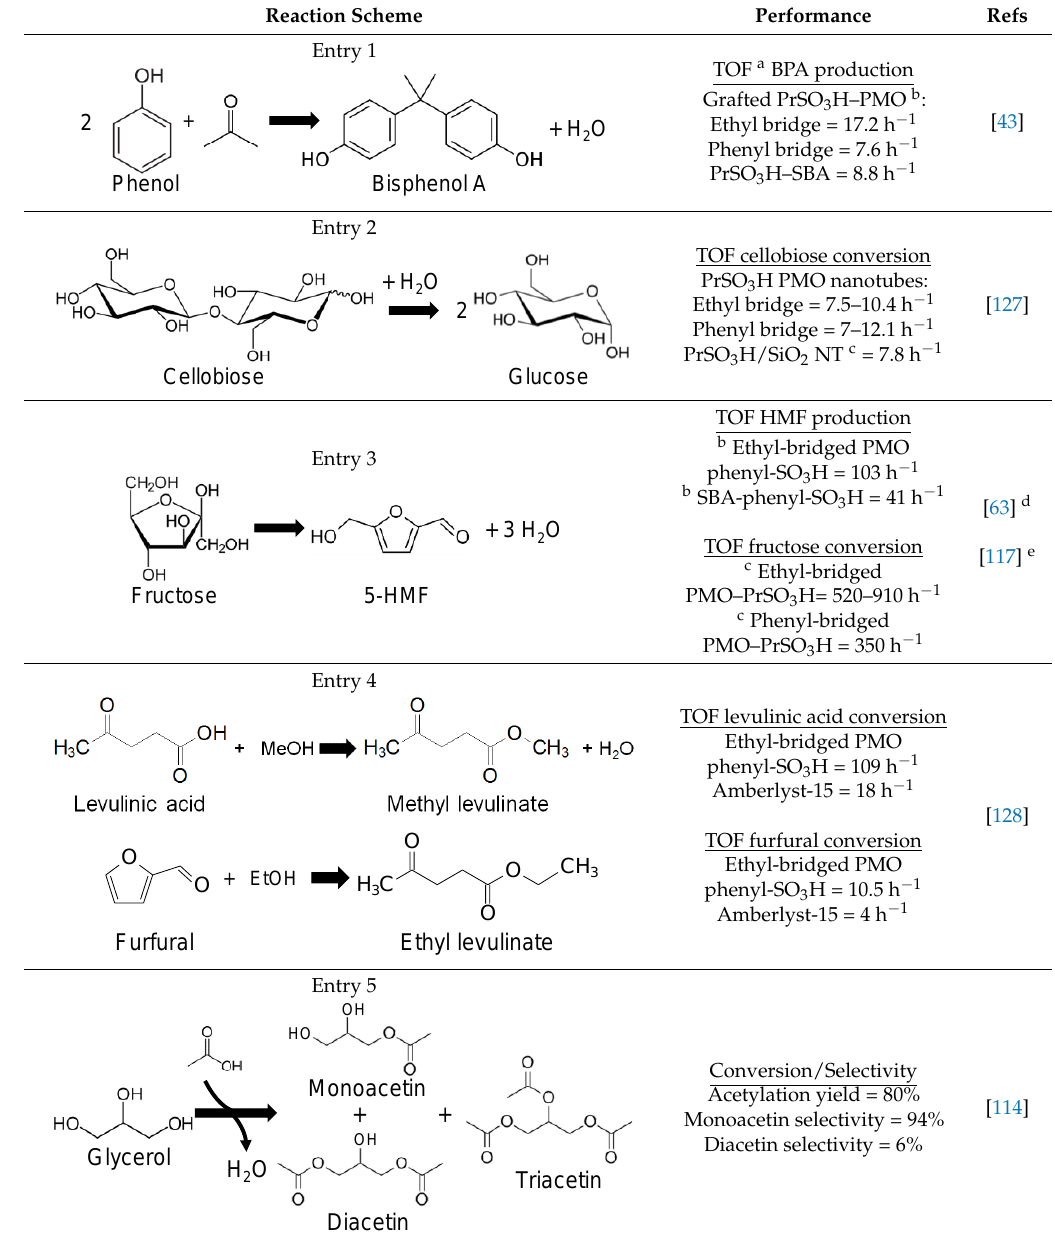
initial gel, which gave materials with optimal hydrophobicity to eliminate water from the acid site, and highest acid-site loadings and surface areas [126]. Table 1. Reaction schemes and performance of periodic mesoporous organosilica (PMO) sulfonic Table 1. Reaction schemes and performance of periodic mesoporous organosilica (PMO) sulfonic Table 1. Reaction schemes and performance of periodic mesoporous organosilica (PMO) sulfonic acids. Entry 1 — condensation of phenol with acetone to bisphenol A (BPA); Entry 2 — hydrolysis of acids. Entry 1 — condensation of phenol with acetone to bisphenol A (BPA); Entry 2 — hydrolysis of Table 1. Reaction schemes and performance of periodic mesoporous organosilica (PMO) sulfonic Table 1. Reaction schemes and performance of periodic mesoporous organosilica (PMO) sulfonic acids. Entry 1 — condensation of phenol with acetone to bisphenol A (BPA); Entry 2 — hydrolysis of cellobiose to glucose; Entry 3 — dehydration of fructose to 5-HMF; Entry 4 — alkyl levulinate Table 1. Reaction schemes and performance of periodic mesoporous organosilica (PMO) sulfonic cellobiose to glucose; Entry 3 — dehydration of fructose to 5-HMF; Entry 4 — alkyl levulinate acids. Entry 1 — condensation of phenol with acetone to bisphenol A (BPA); Entry 2 — hydrolysis of acids. Entry 1 — condensation of phenol with acetone to bisphenol A (BPA); Entry 2 — hydrolysis of cellobiose to glucose; Entry 3 — dehydration of fructose to 5-HMF; Entry 4 — alkyl levulinate production via esterification of levulinic acid or furfural; Entry 5 — glycerol esterification with acetic production via esterification of levulinic acid or furfural; Entry 5 — glycerol esterification with acetic acids. Entry 1—condensation of phenol with acetone to bisphenol A (BPA); Entry 2—hydrolysis of cellobiose to glucose; Entry 3 — dehydration of fructose to 5-HMF; Entry 4 — alkyl levulinate cellobiose to glucose; Entry 3 — dehydration of fructose to 5-HMF; Entry 4 — alkyl levulinate production via esterification of levulinic acid or furfural; Entry 5 — glycerol esterification with acetic acid. cellobiose to glucose; Entry 3—dehydration of fructose to 5-HMF; Entry 4—alkyl levulinate production production via esterification of levulinic acid or furfural; Entry 5 — glycerol esterification with acetic production via esterification of levulinic acid or furfural; Entry 5 — glycerol esterification with acetic acid. via esterification of levulinic acid or furfural; Entry 5—glycerol esterification with acetic acid. acid. acid.